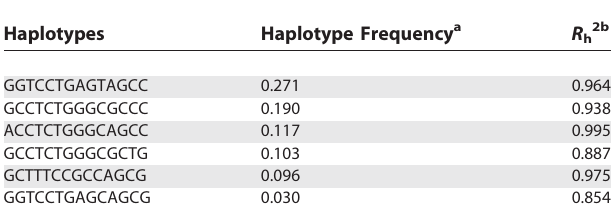
Table 3. Common Haplotypes Reconstructed Using 14 SNPs in CHEK2